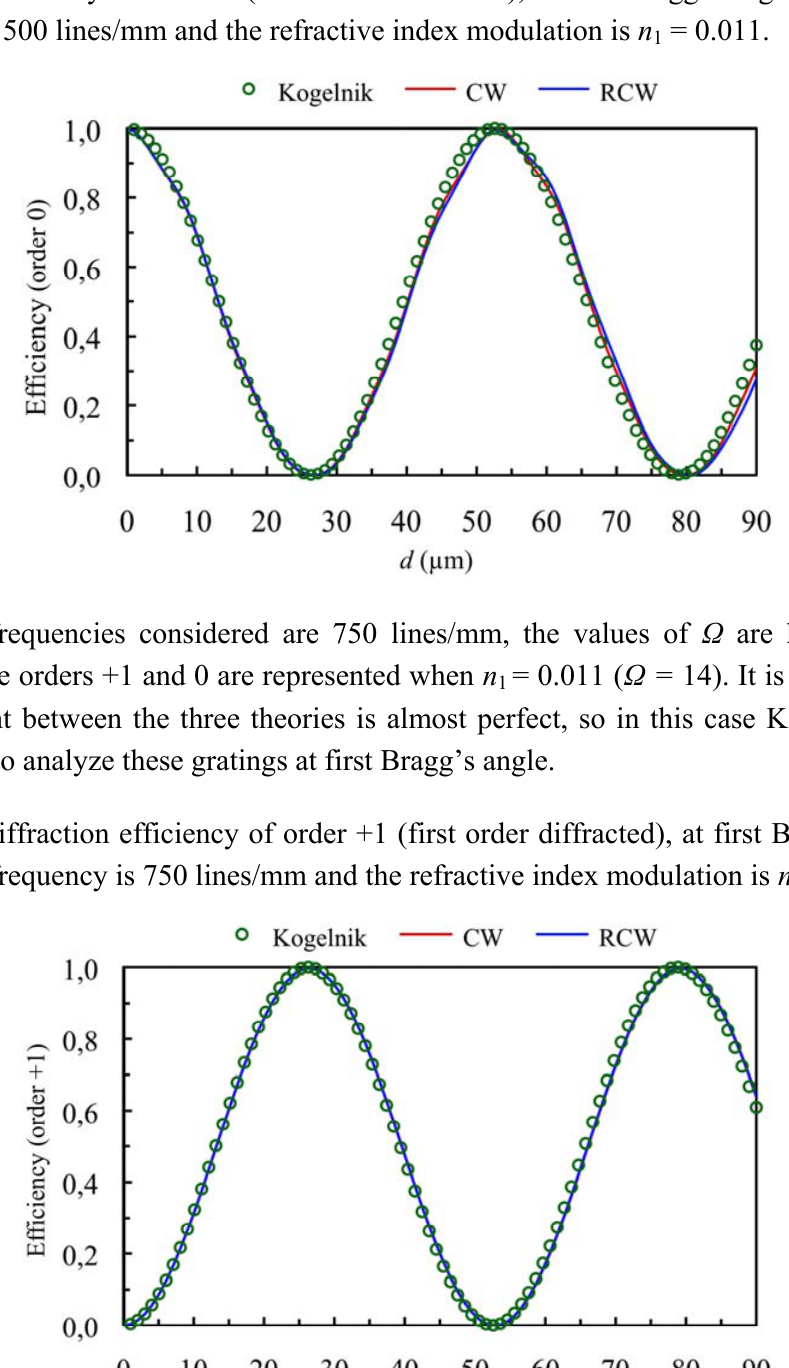
Figure 7. Efficiency of order 0 (zero order diffracted), at first Bragg’s angle. The spatial frequency is 500 lines/mm and the refractive index modulation is n